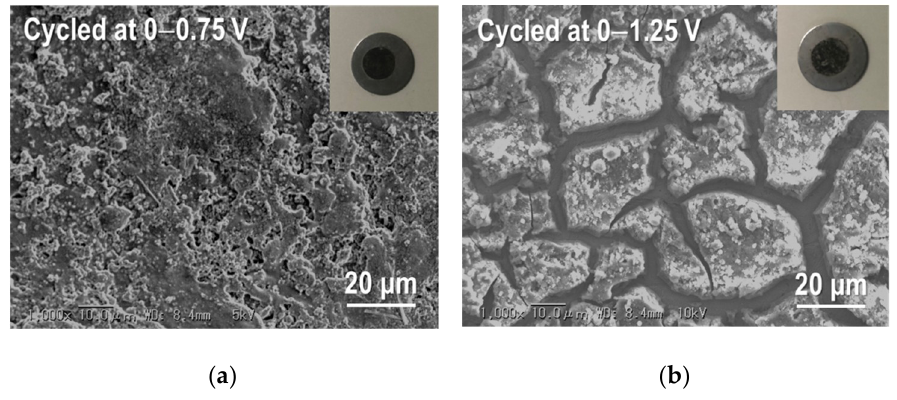
Figure 13. SEM images for the broader surface of Sn 4 P 3 / C composite films taken out of disassembled cells: ( a ) cycled at 0–0.75 V and ( b ) cycled at 0–1.25 V. Insets are the photo images of films.